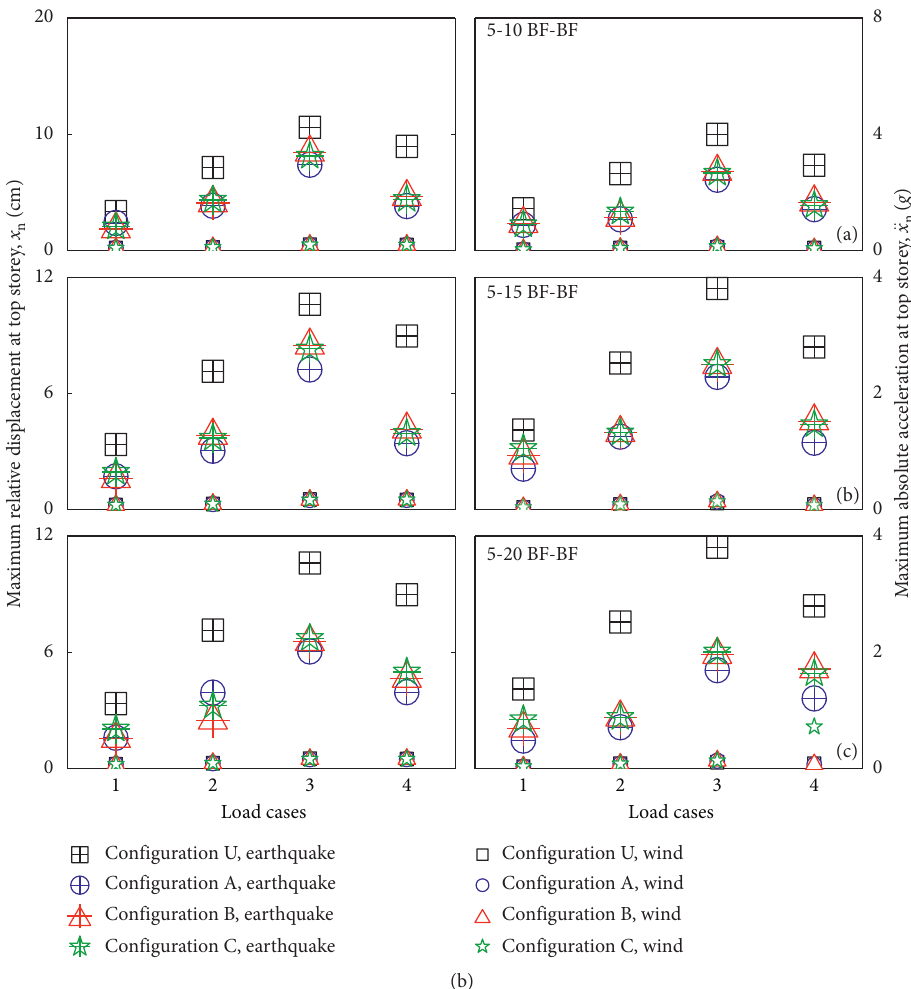
Figure 10: (a) Peak top floor displacement and acceleration responses of the adjacent dissimilar connected MRF-MRF buildings with unequal storey height under historical earthquake ground motions and simulated wind forces. (b) Peak top floor displacement and acceleration responses of the adjacent dissimilar connected BF-BF buildings with unequal storey height under historical earthquake ground motions and simulated wind